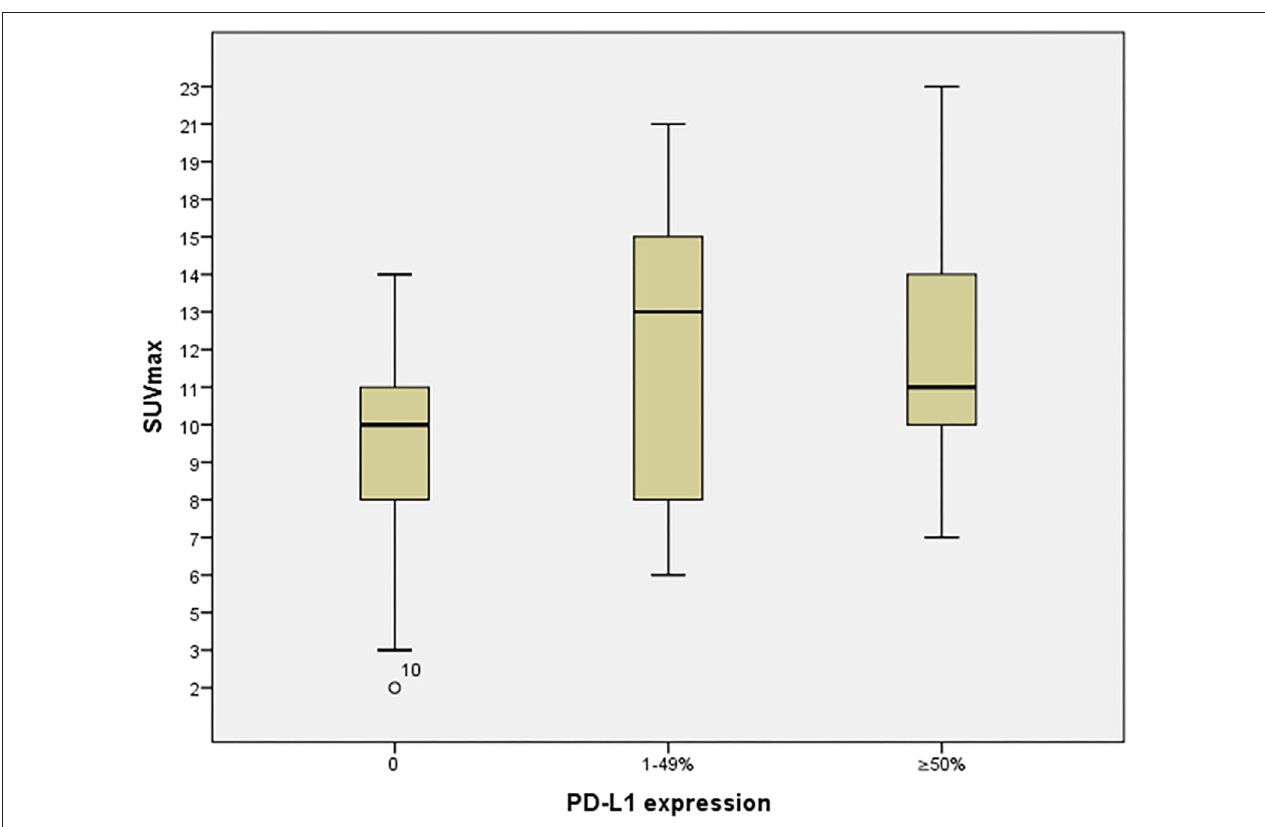
FIGURE 4 | The relationships between SUV max and PD-L1 expression.